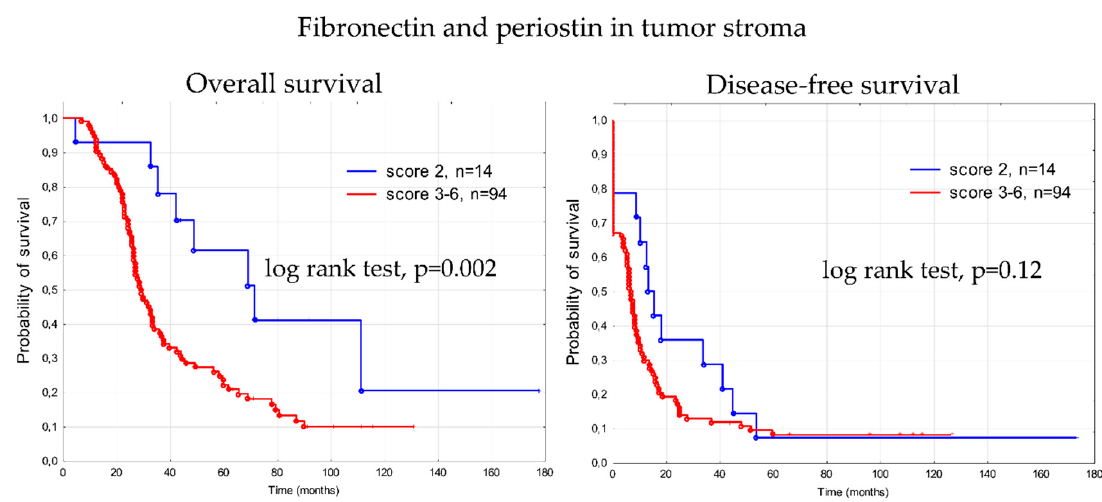
Figure 10. Kaplan-Meier analysis of overall survival (OS) and disease-free survival (DFS) in 108 patients with advanced ovarian cancer stratified by combined FN1&POSTN scores (score 2 versus score 3–6).